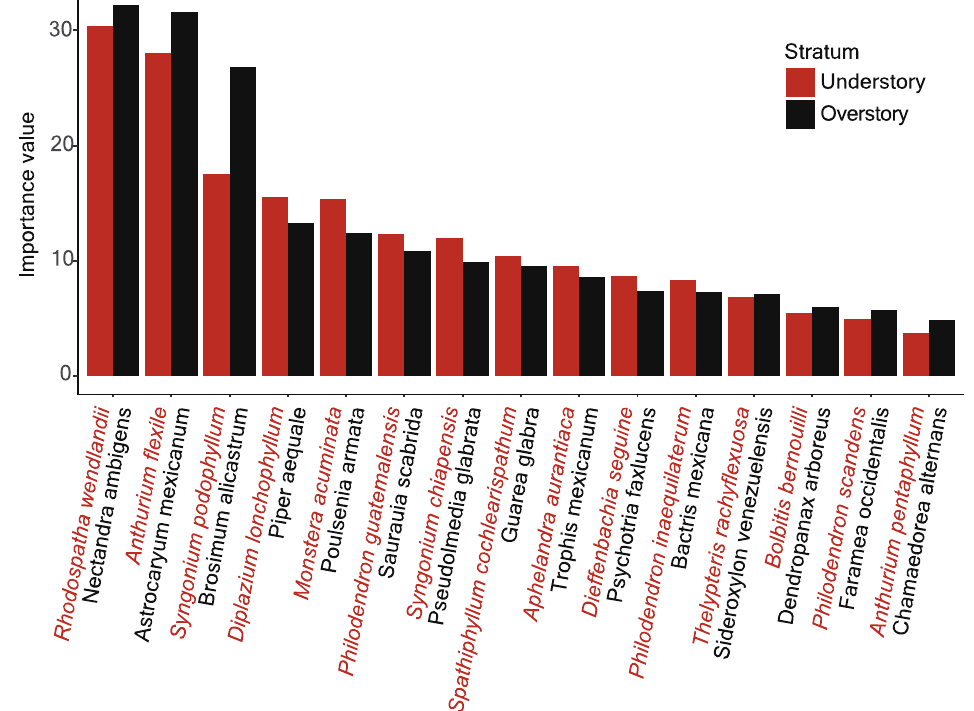
Figure 2. The fifteen most important overstory and understory species arranged by decreasing order of IVI.